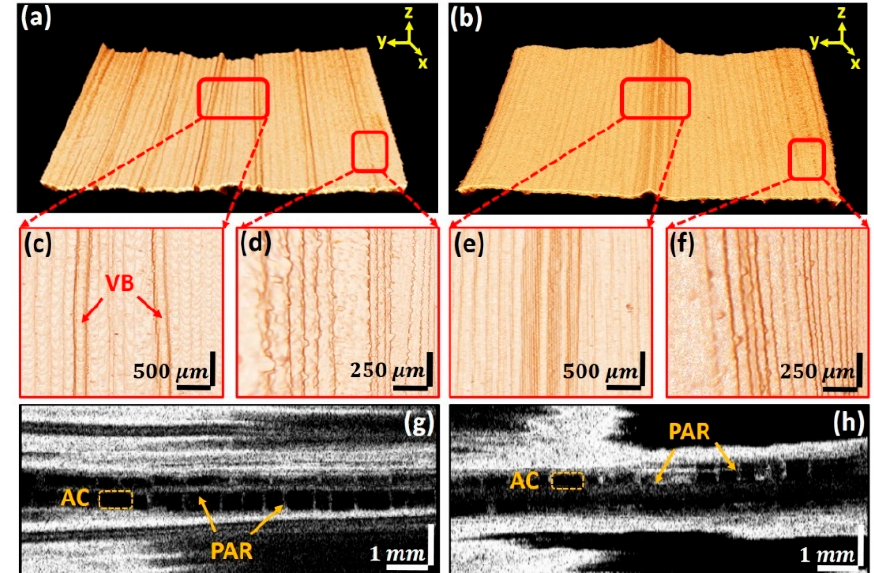
Figure 5. Reconstructed 3D-OCT images of rice leaf specimens. ( a ) Front surface of reconstructed 3D-OCT image, ( b ) rear surface of reconstructed 3D-OCT image. ( c – f ) Magnified image of the red square box indicated in ( a , b ); ( g , h ) are en-face images of mid-vein part of ( a , b ). AC: Aerenchyma, PAR: parenchyma and VB: vascular bundle. The en-face visualizations are rotated by 90 degrees in relation to the rest of the 3D renders.